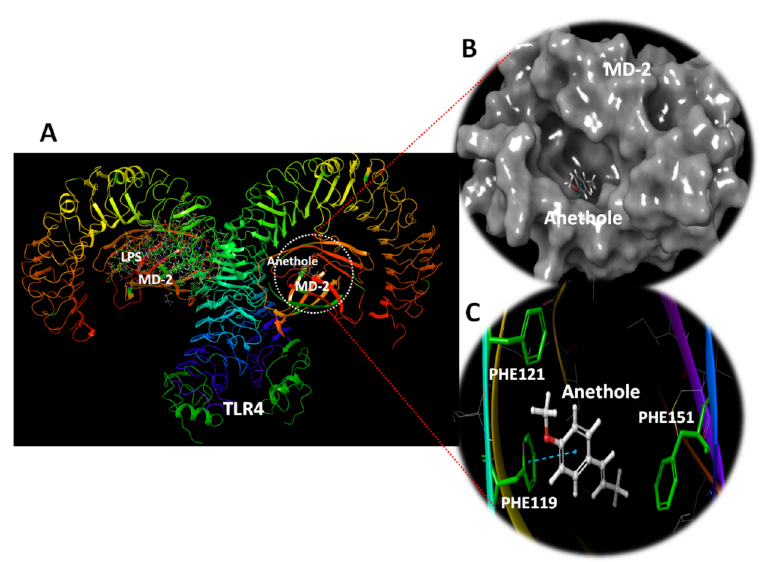
Figure 7. TLR4 complex with MD-2 exhibiting the docking site anethole. ( A ) The docking site of anethole in MD-2. The second MD-2 molecule was left bound with LPS for demonstration. ( B ) Surface depiction of MD-2 showing the docked anethole in the deep hydrophobic cavity of MD-2. ( C ) The docking site of anethole revealing its hydrophobic site comprising PHE119, PHE121, and PHE151. Stacking interaction is reported with